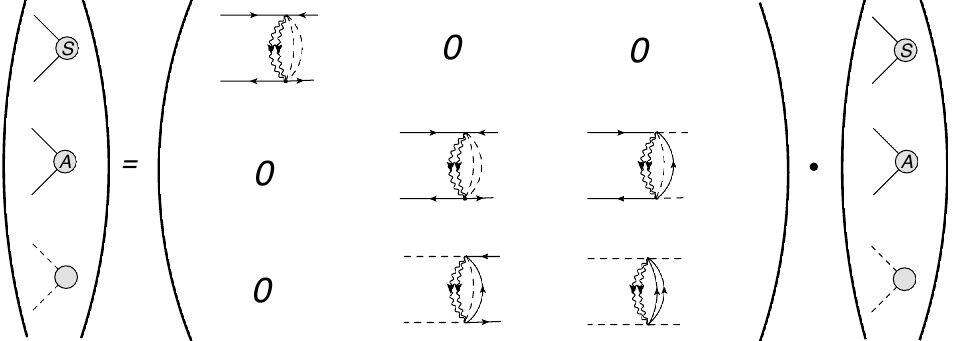
Figure 5 . Schematic form of the eigen-equations associated to the kernels of the 4-point functions in the model (3.1). The solid, dashed and wavy lines represent the vector fermions, the vector bosons and the tensor (cid:12)elds respectively. The letters in the blobs of the eigenvectors indicate whether it is the symmetric or antisymmetric